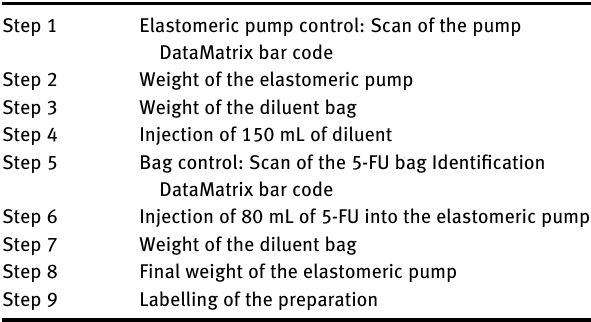
Table  : Steps necessary for the automated preparation of the elastomeric